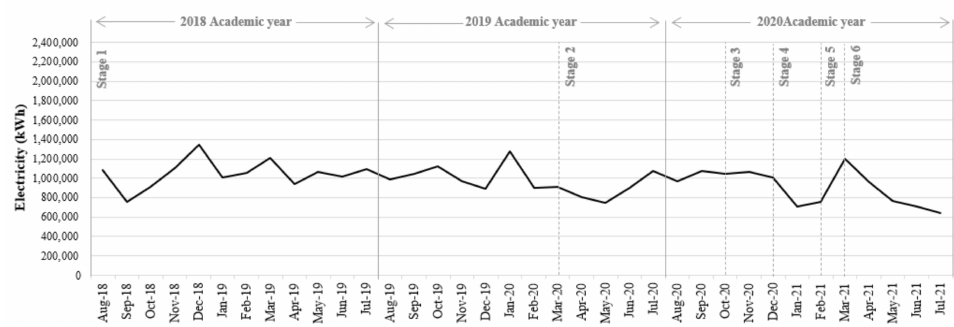
Figure A2. Electricity consumption of the research type during AY2018 to